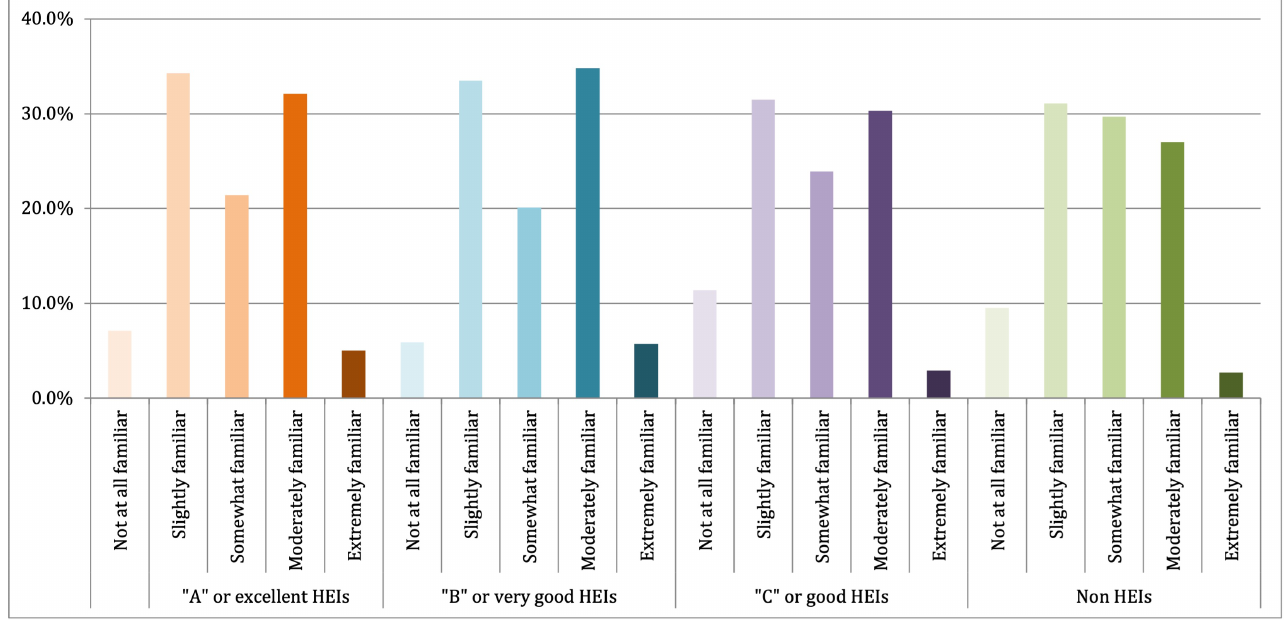
Figure 8. Indonesian scientists’ perceptions of their level of knowledge on the best practices in research data